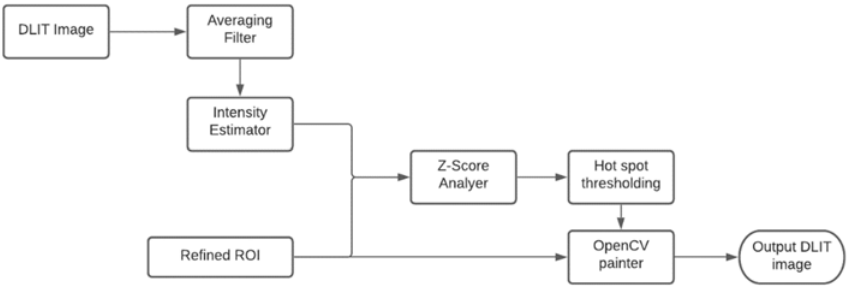
Figure 17. Schematic diagram of hot spot detection and ROI